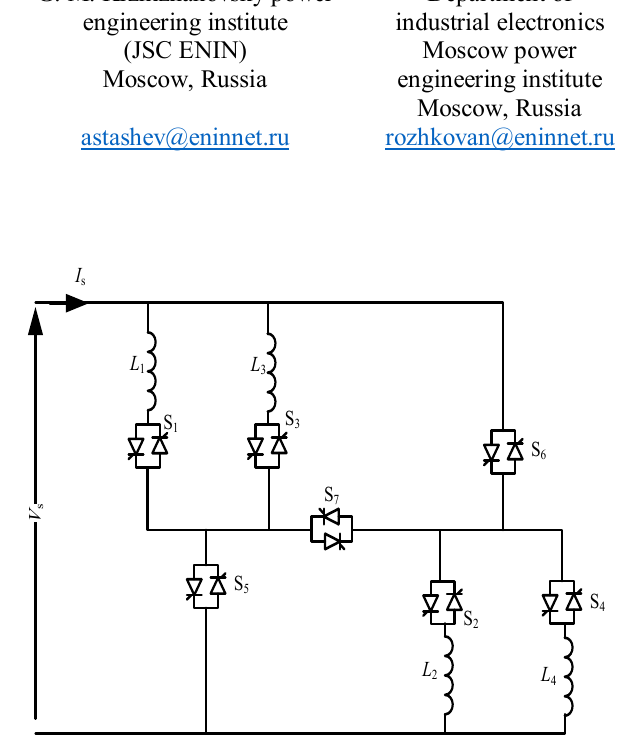
Fig. 1. TSR with 25 power